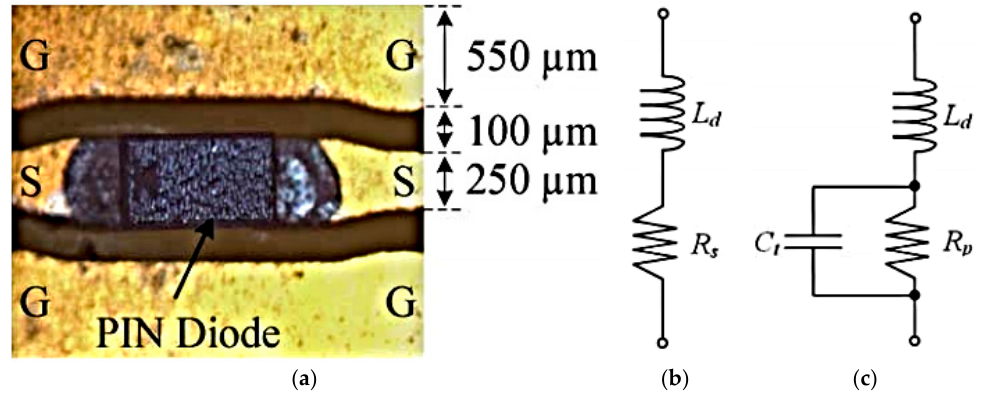
Figure 1. ( a ) Embedded positive–intrinsic–negative (PIN) diode on a prototype, equivalent models for ( b ) forward and ( c ) reverse biases (redrawn from [33]).